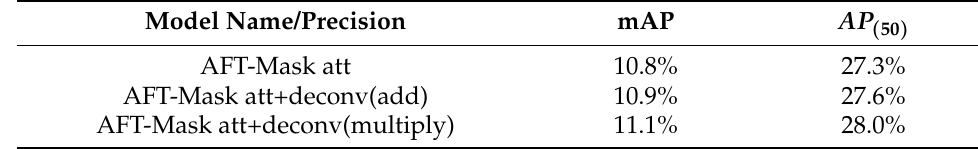
Table 2. Comparison of segmentation accuracy of AFT-Mask model examples with different structures.